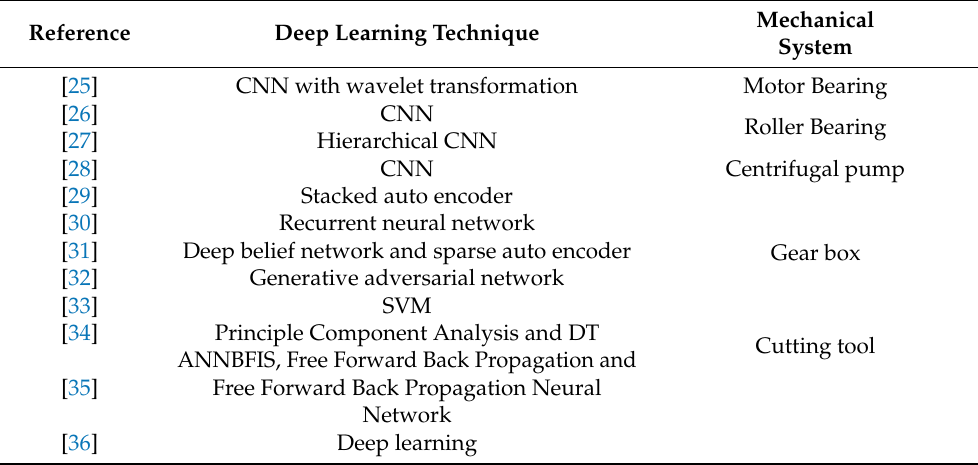
Table 1. Several studies on DL-based techniques for mechanical